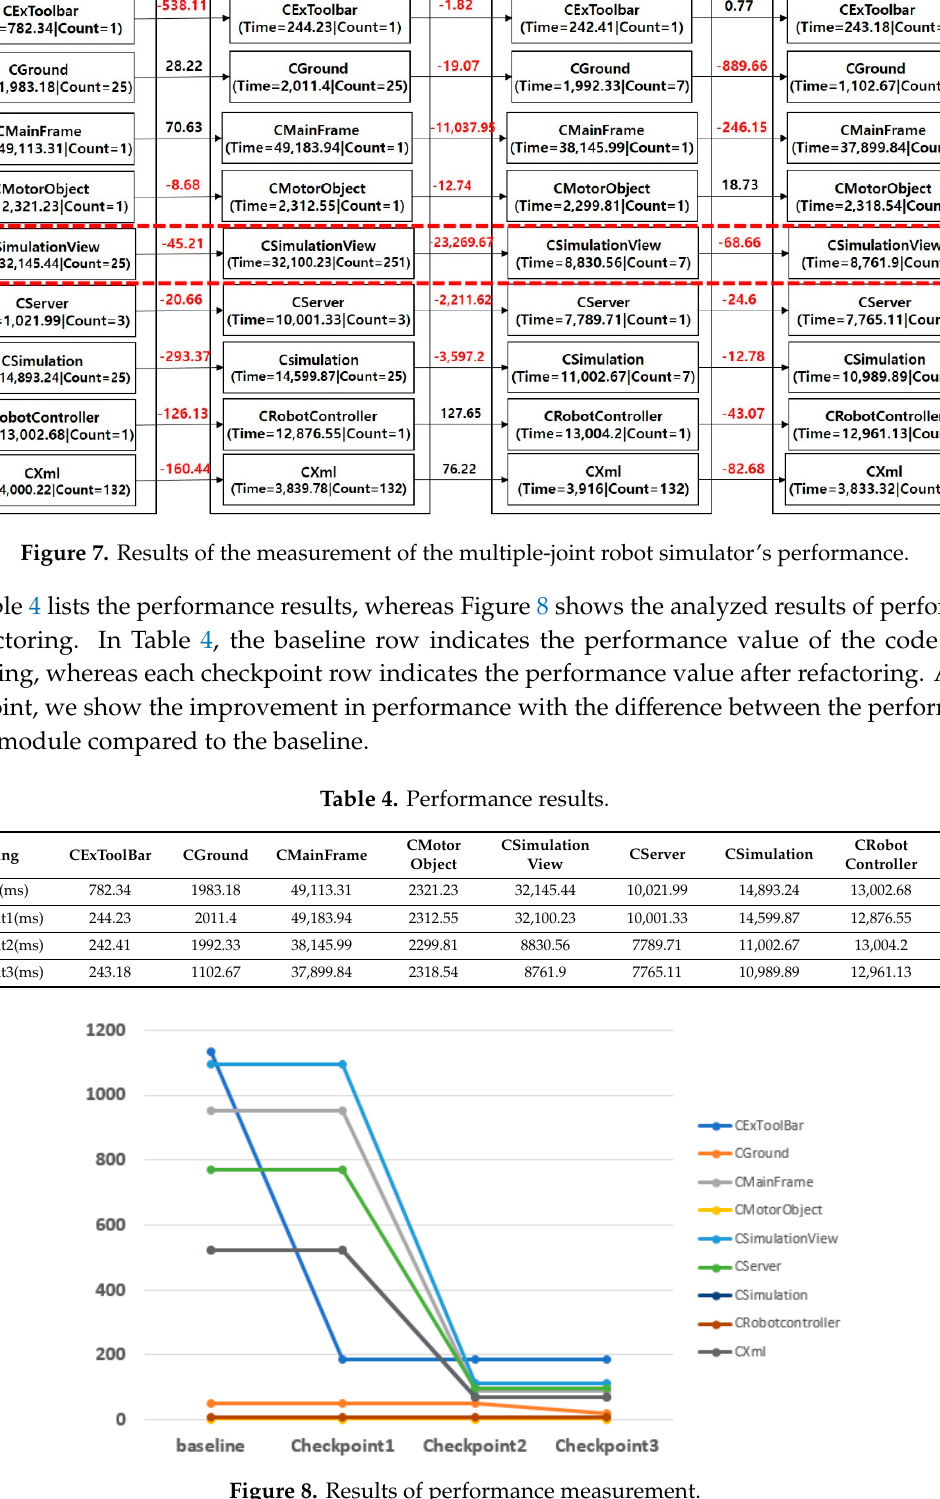
Figure 8. Results of performance measurement.